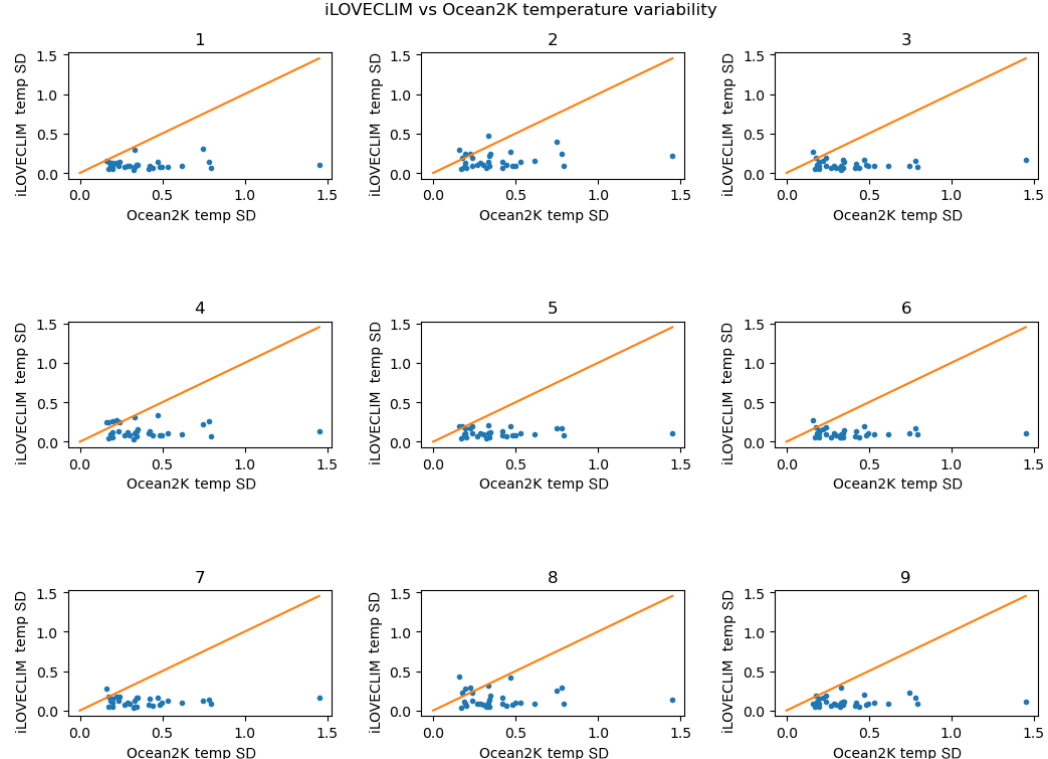
Figure A11. Local Ocean2K (McGregor et al., 2015) SST variability versus simulated i LOVECLIM SST variability at the same sites for the i LOVECLIM ensemble members.